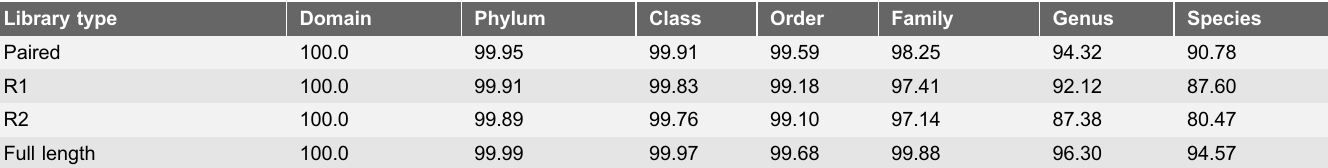
Table 1. Taxonomy